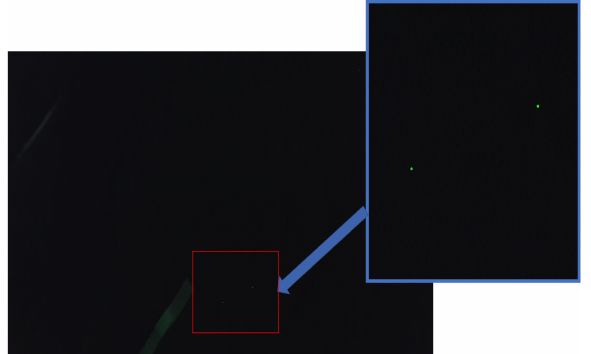
Figure 12. Image with false positive